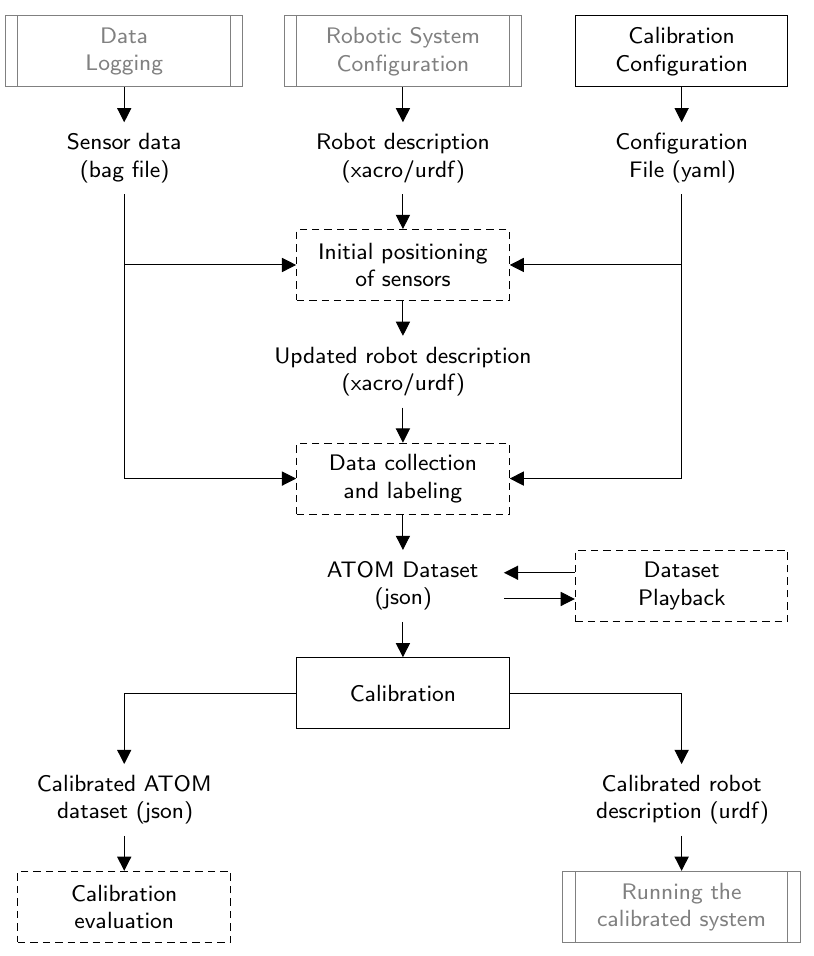
Figure 4. The software architecture for the ATOM calibration framework is composed of modules external to ATOM (presented in grey) and modules internal to ATOM (presented in black). Some modules are not mandatory and are presented inside a dotted bounding box.